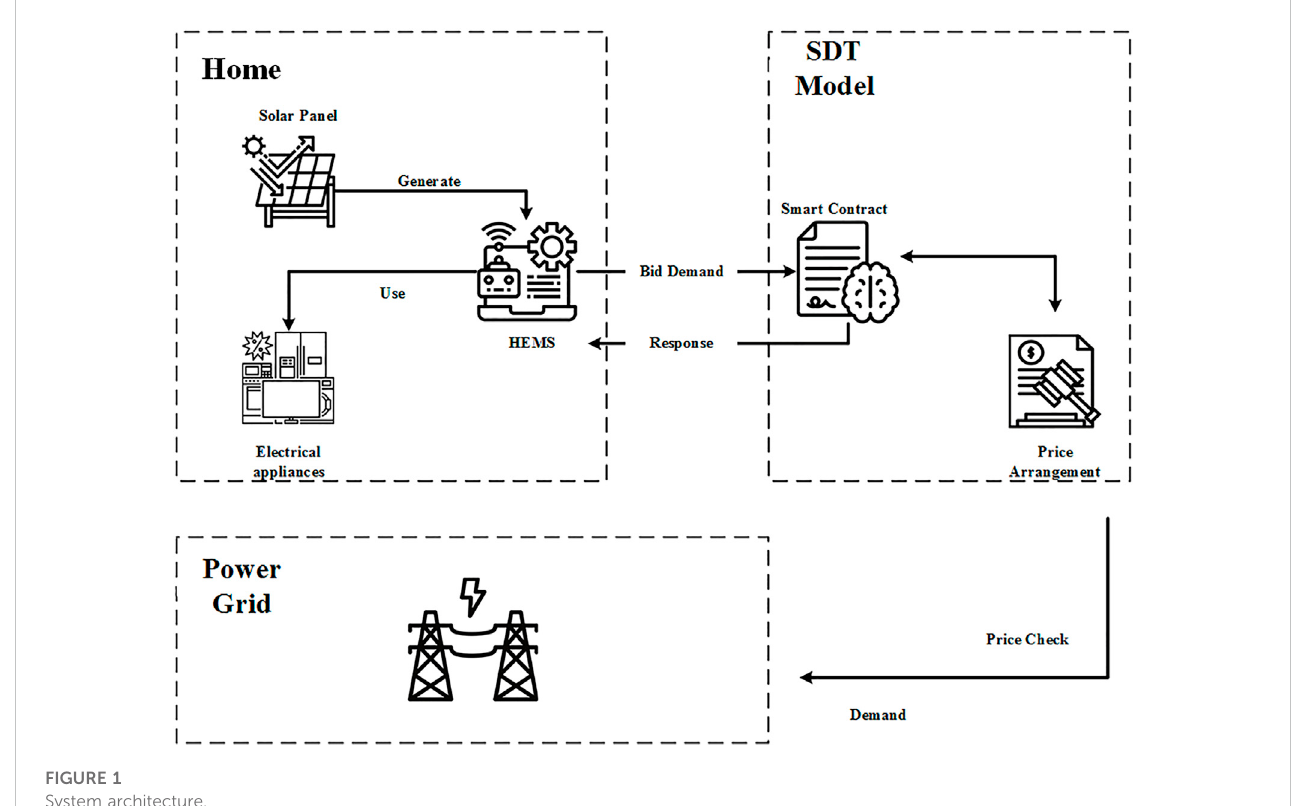
FIGURE 1 System